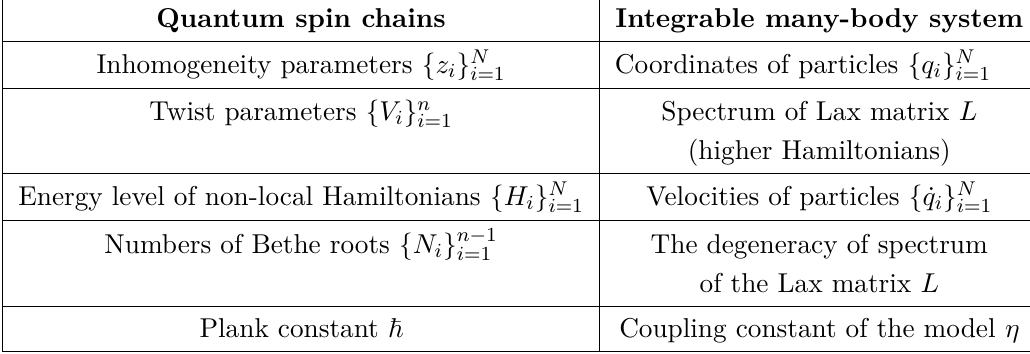
Table 1 . QC-duality